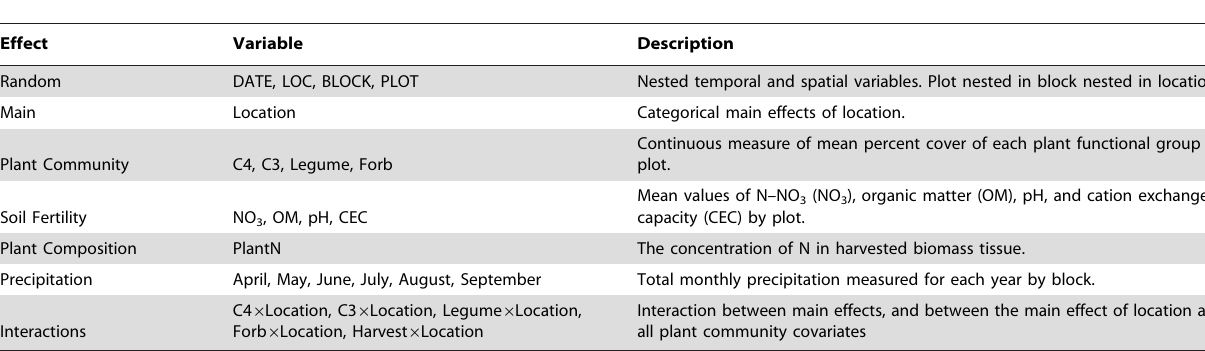
Table 1. List and description of all covariates available for analysis.